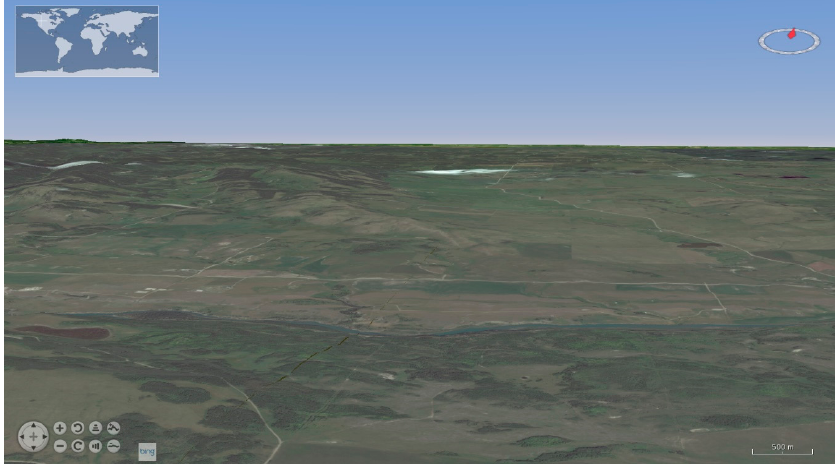
Figure 8. A three-dimensional (3D) visualization with some hills and farm land superimposed over a Bing aerial two-dimensional (2D) map and data at an area near Cochrane, Alberta (51.1830, − 114.4742). Geospatial information plays an important role in environmental modelling, resource management, business operations, government policy, and in enhancing the quality of life. Currently,